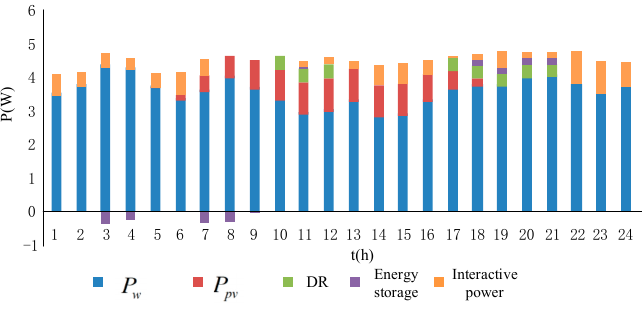
Figure 8. Optimized scheduling scheme for unconnected EV.